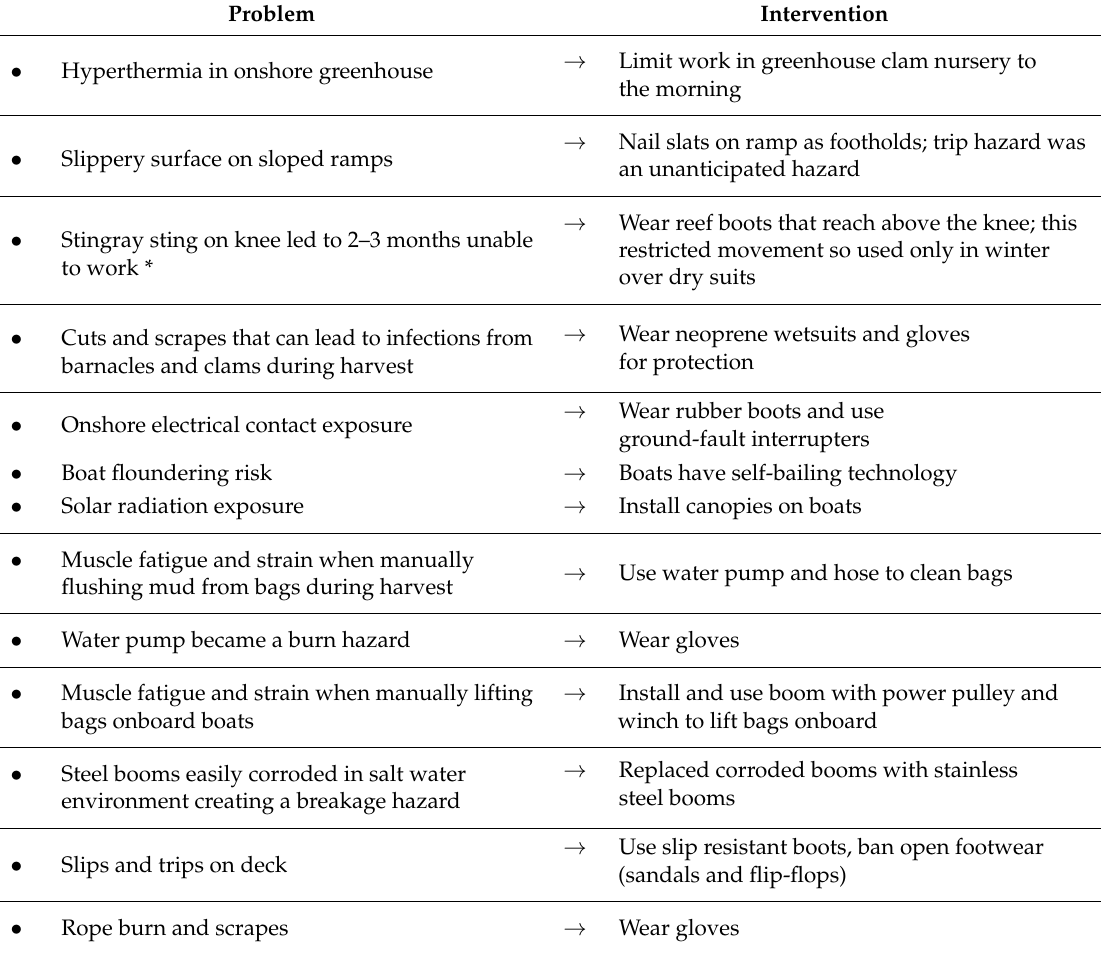
Table 3. Observations from a case study based on an interview and tour of a clam mariculture farm in South Carolina regarding hazards and simple solutions for the prevention of work-related injuries and diseases,